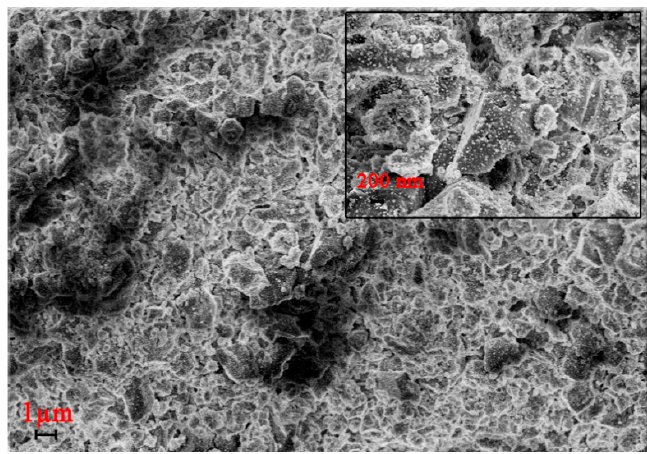
Figure 11. SEM image of thermolysis products of copper trimesinate obtained by method A.